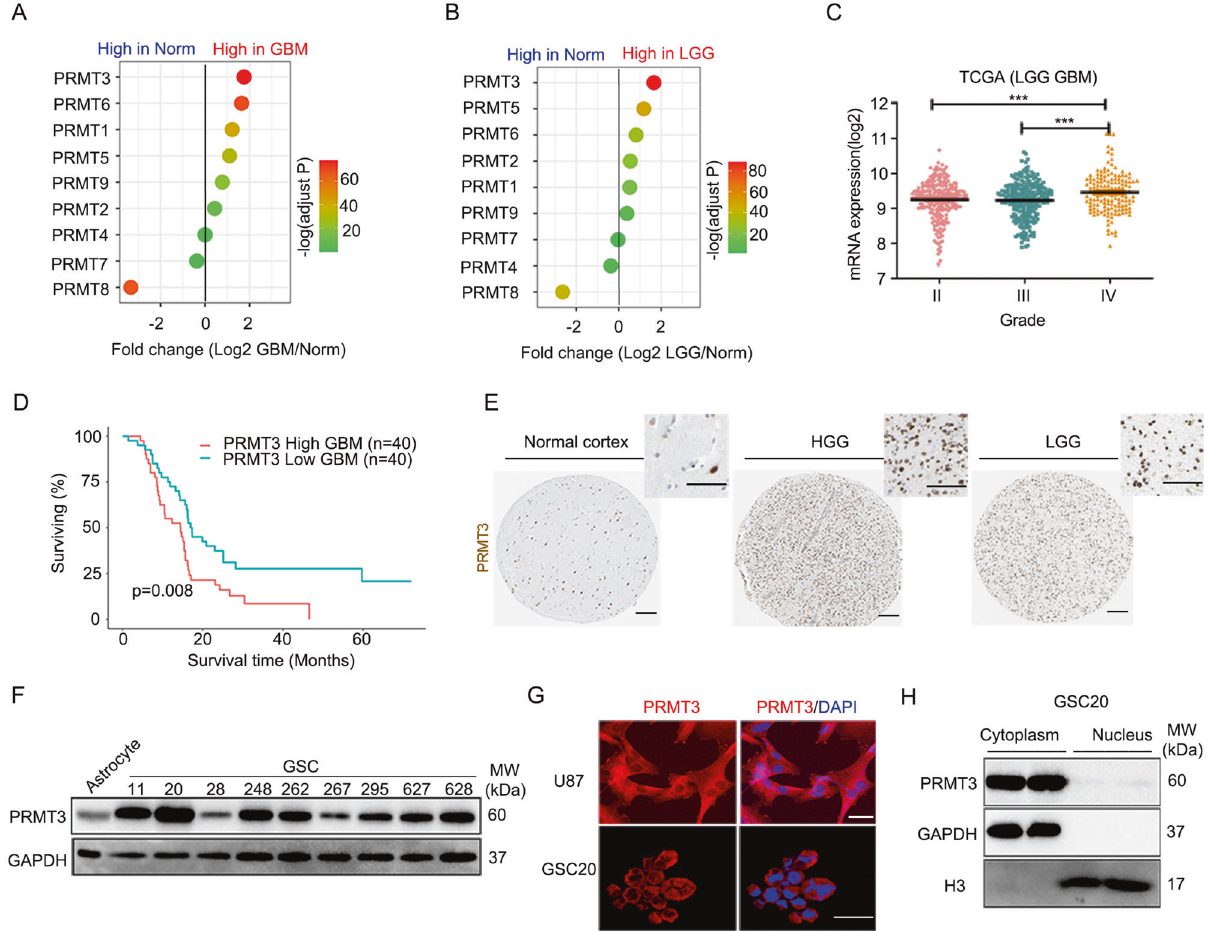
Fig. 1 PRMT3 is overexpressed in GBM and negatively correlated with prognosis. A , B The differential expression of PRMT genes in the TCGA GBM ( A ) and LGG ( B ) datasets. C PRMT3 expression levels in grade IV GBMs are the highest among TCGA gliomas. D Kaplan-Meier survival curve for PRMT3 in GBMs. Figure was created using GlioVis data portal (http://gliovis.bioinfo.cnio.es/). E Immunostaining of PRMT3 in the normal cerebral cortex, HGG, and LGG tissues from the Human Protein Atlas. Scale bars, 100 μ m. F Western blot of PRMT3 expression in human astrocytes and GSC11, GSC20, GSC28, GSC248, GSC262, GSC267, GSC295, GSC627 and GSC628 cells. G , H Immuno fl uorescence assays ( G ) and western blot ( H ) of GBM cells showing the localization of PRMT3. Scale bars, 25 μ